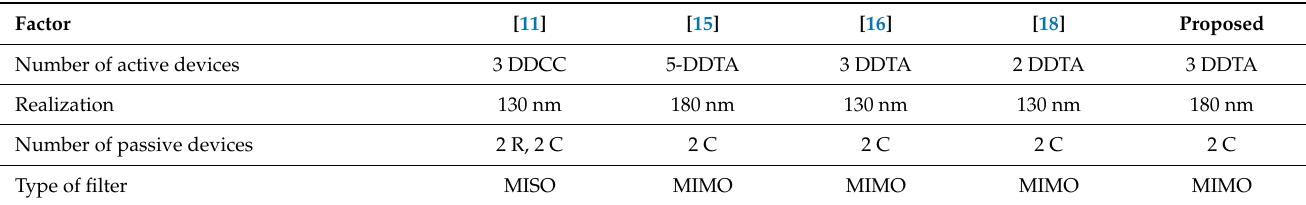
Table 4. Performance comparison of this work with those of recently